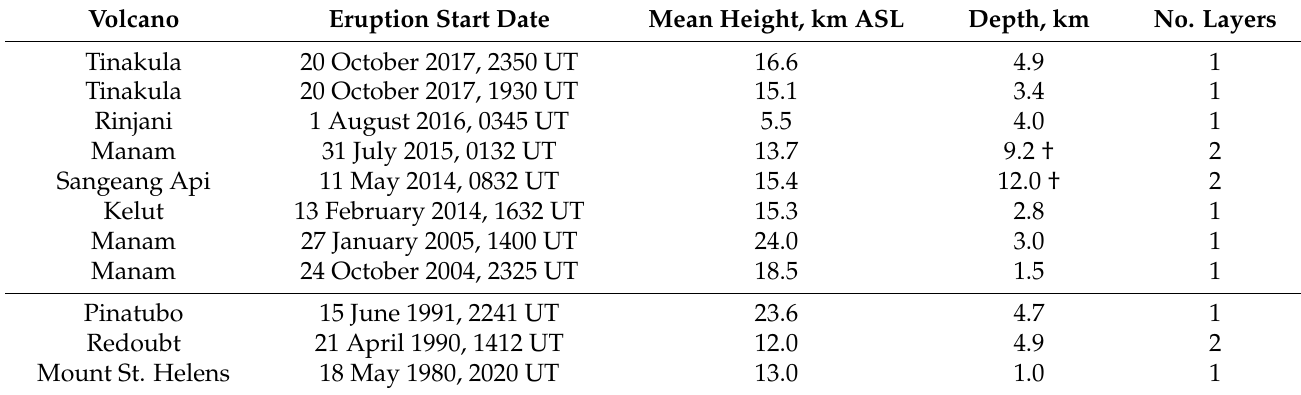
Table 1. Examples of near-source, upper volcanic cloud depth from the top to lowest part near the cloud edge. Measured from geostationary imagery in first scene after eruption start (photography for Redoubt). Data from Bear-Crozier et al. [47]; and Pouget et al. [48] and Holasek et al. [7] (below